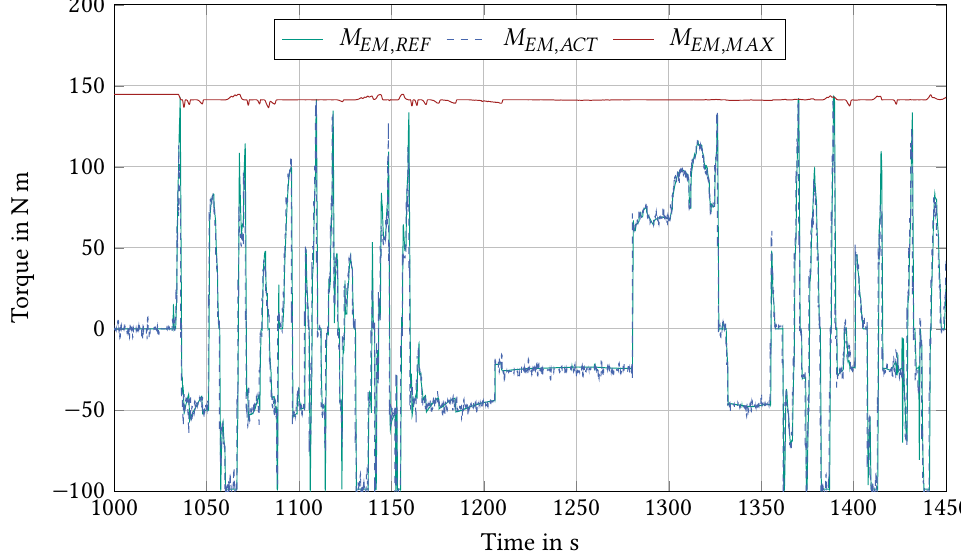
Figure 9. Reference M EM , REF and actual torque M EM , ACT of the EM in a WLTC compared to the maximum permitted torque M EM , MAX